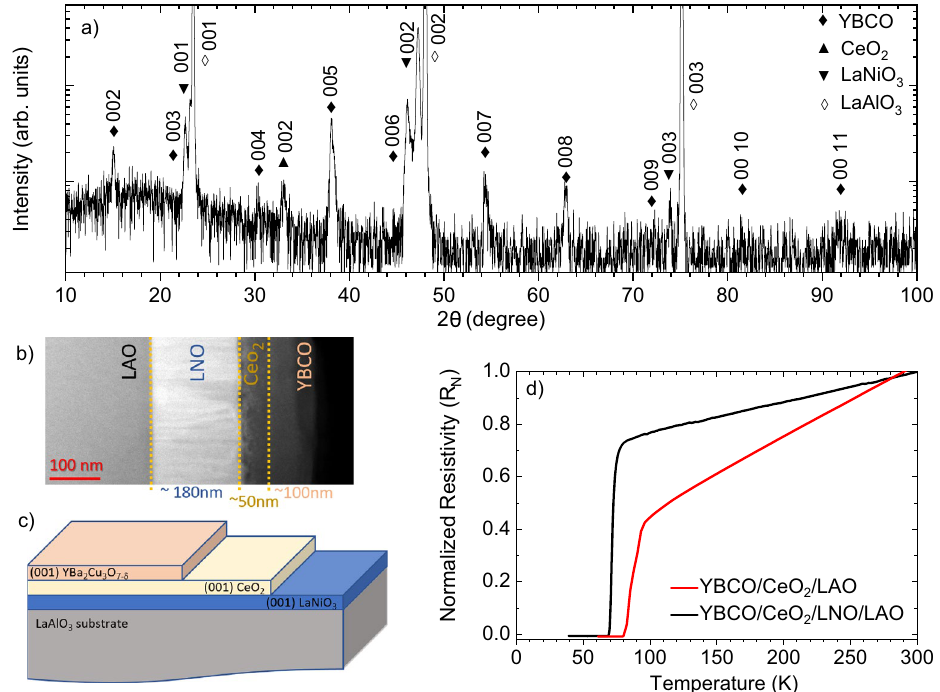
Figure 6. ( a ) θ − 2 θ scan of the YBCO/CeO 2 /LNO heterostructure grown on LAO [0 0 1] substrate, ( b ) a cross-sectional HAADF-STEM image and ( c ) a schematic representation of the YBCO/CeO 2 /LNO/LAO heterostructure stack; ( d ) room-temperature normalized resistance vs temperature behavior of the YBCO/CeO 2 zero and YBCO/CeO 2 /LNO stack displaying T c ∼ 80 K and 70 K